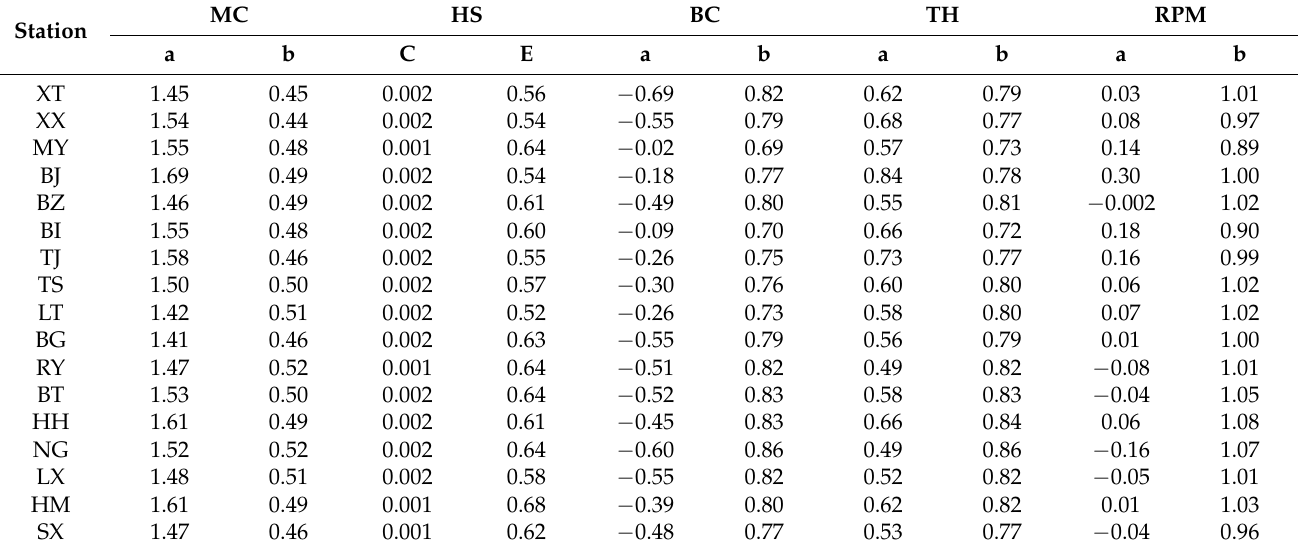
Table 4. Calibrated parameters for the five